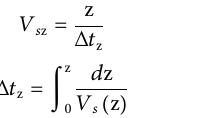
FIGURE 3 Distribution of selected measured data, red dots represent the borehole